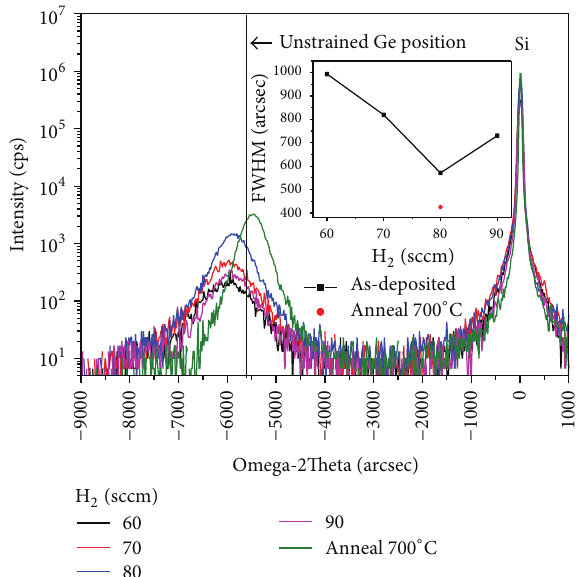
Figure 1: High resolution XRD rocking curve of the Ge (004) peak with various H 2 flow rate.